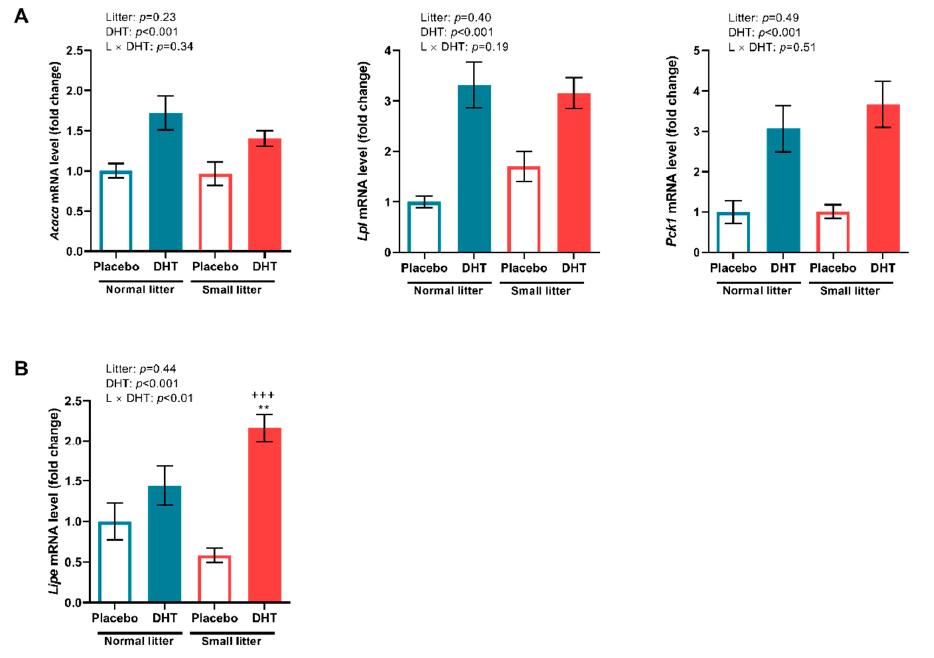
Figure 5. Relative expression of lipogenesis and lipolysis markers in the SAT of placebo and DHT treated rats from small and normal litters. ( A ) Relative expression of Acaca , Lpl and Pck1 genes. ( B ) Relative expression of Lipe gene. The expression of the genes was normalized to the expression of Tbp or B2m gene and the data are presented as mean ± SEM ( n = 6 animals per group). To determine the effects of litter size reduction and DHT treatment, as well as their interaction, two-way ANOVA, followed by Tukey post hoc test was performed, and the difference was considered significant at p < 0.05. Symbols denote a statistically significant difference between NL-Placebo and SL-DHT groups (** p < 0.01), or between SL-Placebo and SL-DHT groups ( +++ p <